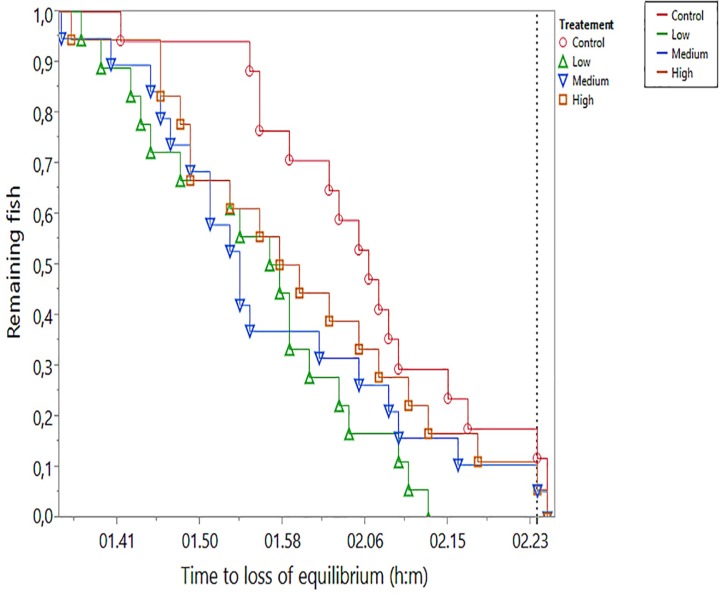
Time to hypoxia-induced loss of equilibrium (LOEhyp) in the four experimental treatments. Oxygen saturation during the period of LOEhyp decreased gradually from 23 to 17% saturation. The vertical dotted line indicates termination of the test, at which point seven (3, 0, 2, and 2 in control, low-, medium-, and high-treatment groups, respectively) fish remained in the tank. Remaining fish were assigned time of termination and 17% O2 saturation.